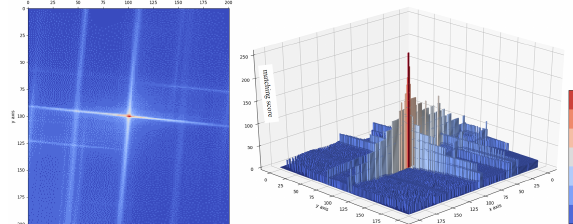
Figure 14. Left: An example of a score map image resulted from image registration (with the parameters described in Table 1). Right: For better understanding of the score map’s concept the score map is also visualized in 3D.